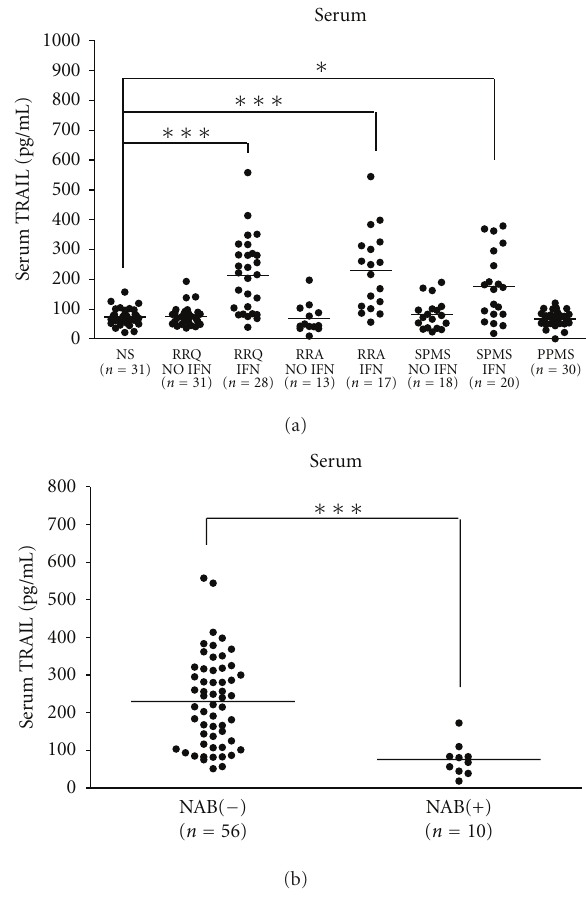
Figure 4: Absolute quantification of soluble TRAIL protein in peripheral blood serum. (a) Levels of soluble TRAIL protein were increased in serum from IFN- β treated-patients irrespective of subgroup (RRMS, SPMS) or disease activity (RRQ, RRA) relative to NS and untreated MS patients. ∗ P < . 05, ∗∗ P < . 01, and ∗∗∗ P < . 001, Dunn’s post-hoc test. (b) Ten patients (RRQ IFN n = 4; RRA IFN n = 3; SPMS n = 3) that were NAB(+) showed attenuated sTRAIL levels relative to IFN- β NAB( − ) MS patients. ∗∗∗ P < . 001, Mann Whitney U